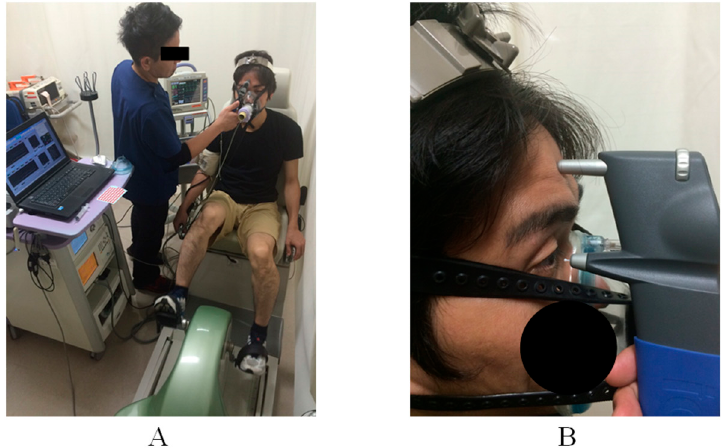
Figure 1. ( A ) Measurement of intraocular pressure (IOP) during exercise. ( B ) Probe position at rest and during exercise measuring IOP.